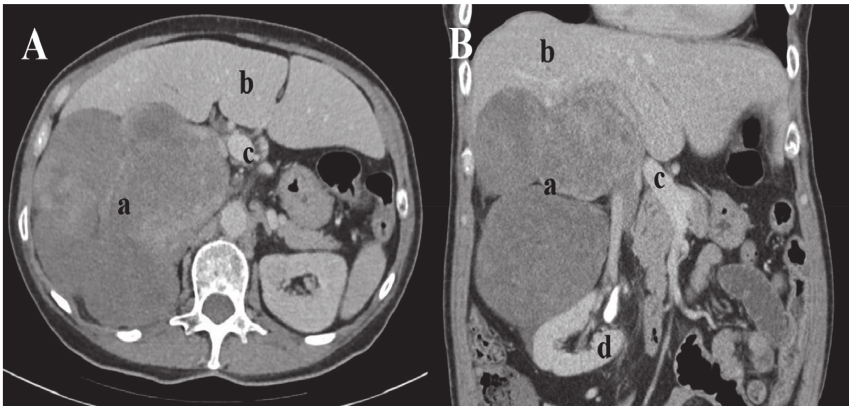
Figure 1: CT Scan of retroperitoneal mass. (a) Axial slice of contrast enhanced CT of the abdomen demonstrating a large right retro- peritoneal tumor (A) with mass effect upon the right lobe of the liver (B) and displacement of the vena cava and porta hepatis (C) medially. (b) Coronal slice of contrast enhanced CTof the abdomen again showing the tumor, with displacement of the right kidney (D) inferiorly.